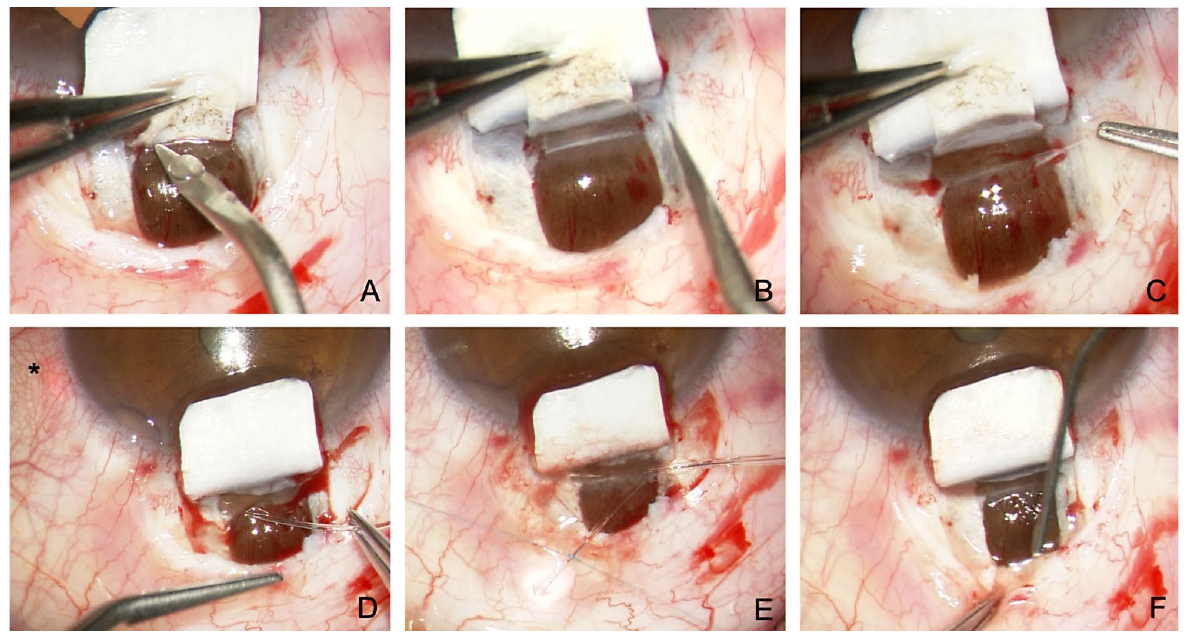
Figure 5. Surgical technique of modified canaloplasty with suprachoroidal drainage. ( A ) Preparation of a second deep flap with incision down to the choroid and incision anterior to the scleral spur. ( B ) Dissection across the scleral spur opens the SC and TDW. ( C ) Peeling of the juxtacanalicular TMW. ( D ) Probing of the SC with a microcatheter. Asterisk marks the laser light of the catheter tip ( E ) Insertion and knotting of two Prolene 10.0 sutures. ( F ) Dilatation of the suprachoroidal space using viscoelastics.